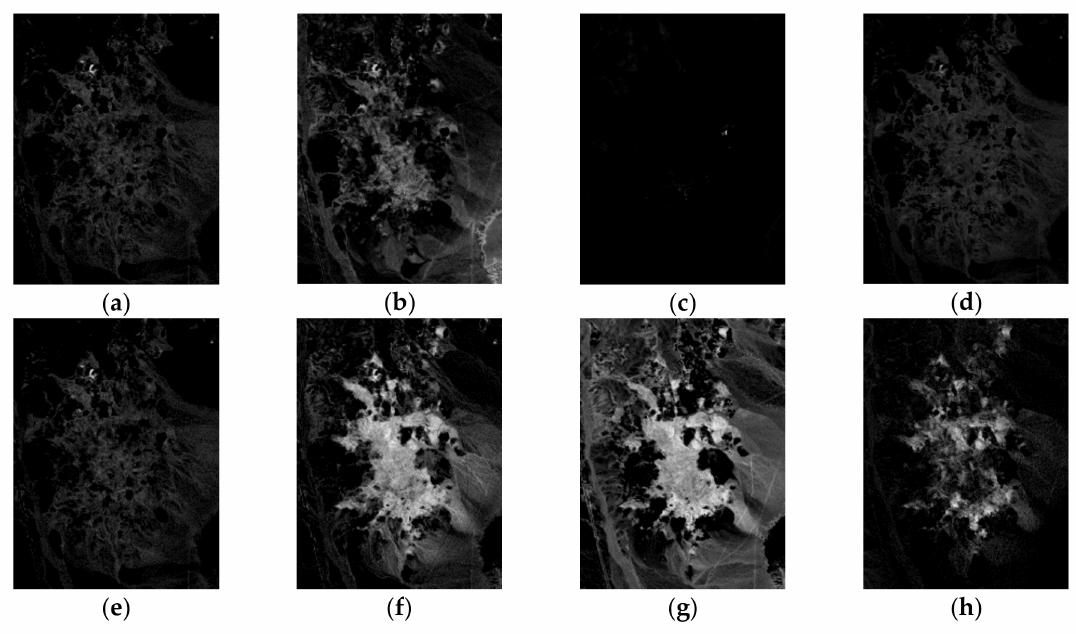
Figure 18. Chalcedony: ( a ) VCA, ( b ) N-FINDR, ( c ) SGA, ( d ) C-NMF, ( e ) MVC-NMF, ( f ) ICE, ( g ) SPICE, ( h )